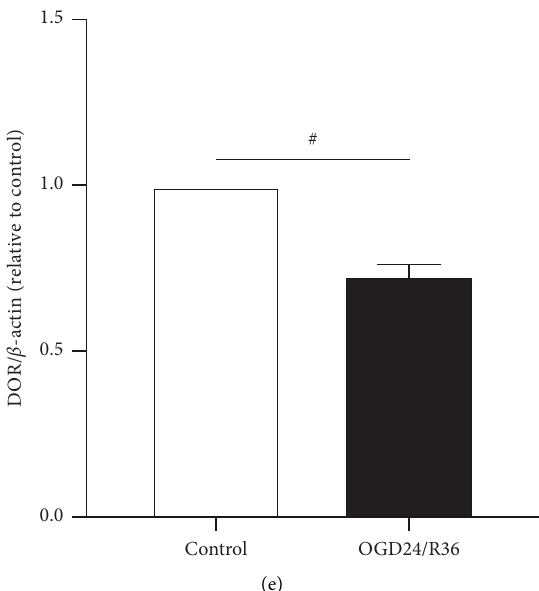
Figure 2: Diferent durations of reoxygenation have diverse efects on DOR and TNF- α protein levels in ARPE19 cells. (a) TNF- α levels in cell lysates after diferent reoxygenation times were measured by ELISA ( n � 5 per group). (b–e) Te protein expression of DOR after diferent reoxygenation times was examined by Western blotting ( n � 3 per group). Quantifcation of the density values of DOR was normalized to those of β -actin. Data are presented as means ± SEM, and group diferences were analyzed by Student’s t -tests. # P < 0 . 05, ## P < 0 . 01, ### P < 0 . 001, compared with the control group; ∗ P < 0 . 05, OGD24/R24 group vs. OGD24/R36 group.